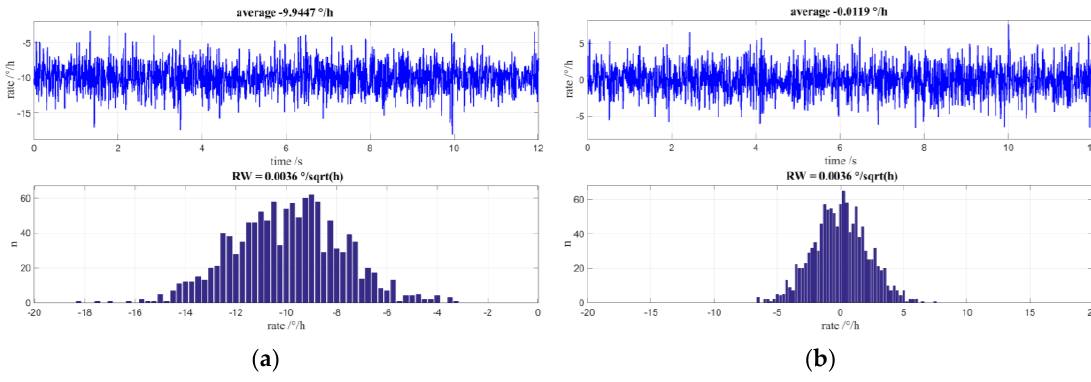
Figure 16. Simulations including non-ideal MIOC transfer function and mean-value-free 4π-Modulation: ( a ) Simulated time signal and value distribution histogram for an applied rotation rate of approximately −10°/h; ( b ) Simulated time signal and value distribution histogram for applied rotation rate of 0°/h.